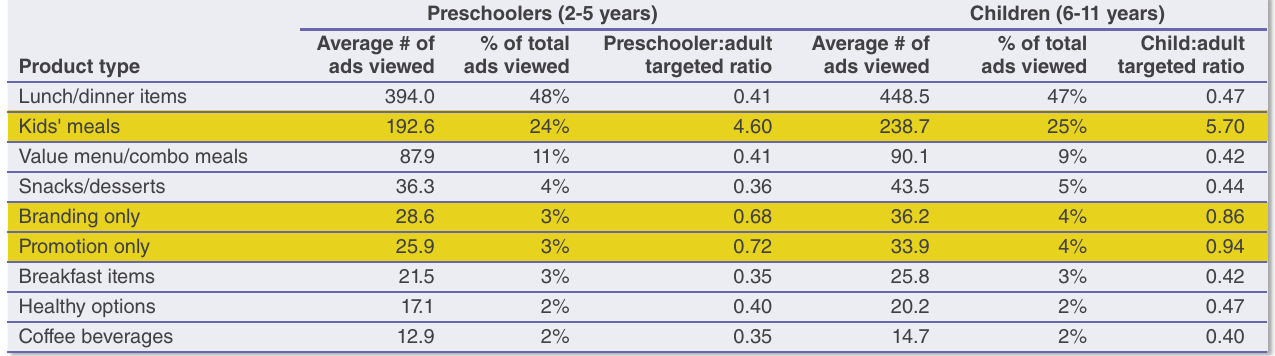
Table 17. Child exposure to TV advertising by product type and age